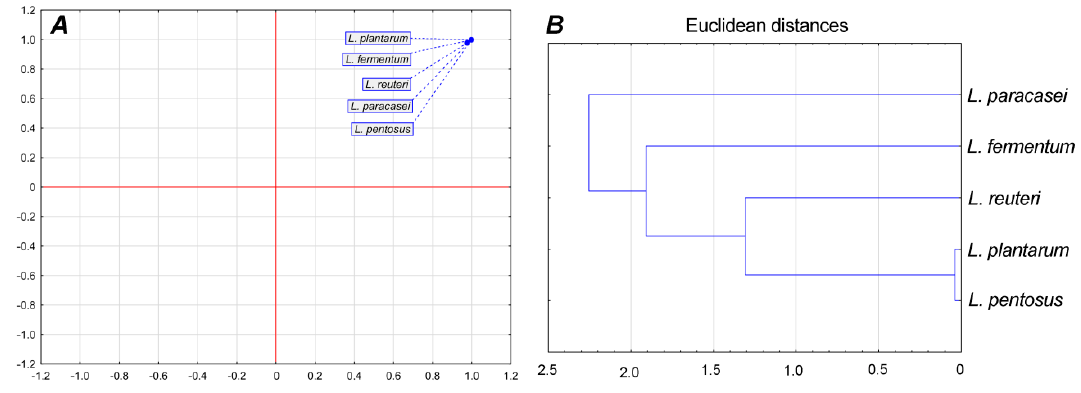
Figure 3. Principal component analysis of growth parameters ( A ) and cluster analysis ( B ).